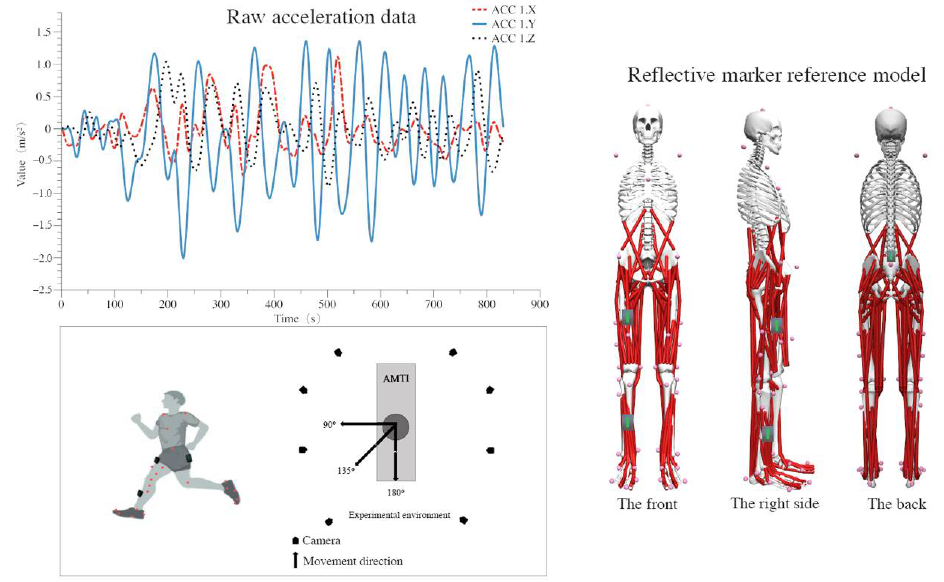
Figure 1. The sensor’s raw data and the diagram of reflective markers.